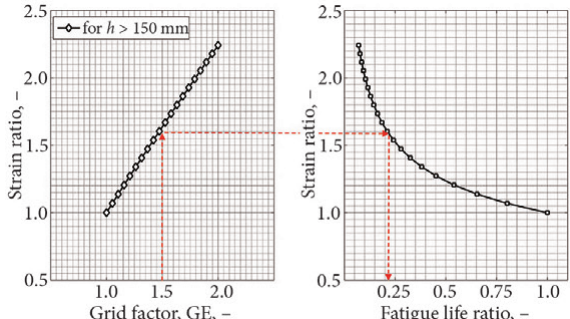
Fig. 4. An example of the effect of grid reinforcement (geogrid factor) on pavement fatigue life: a) relationship between geogrid factor and strain ratio; b) normalized fatigue life as a function of strain